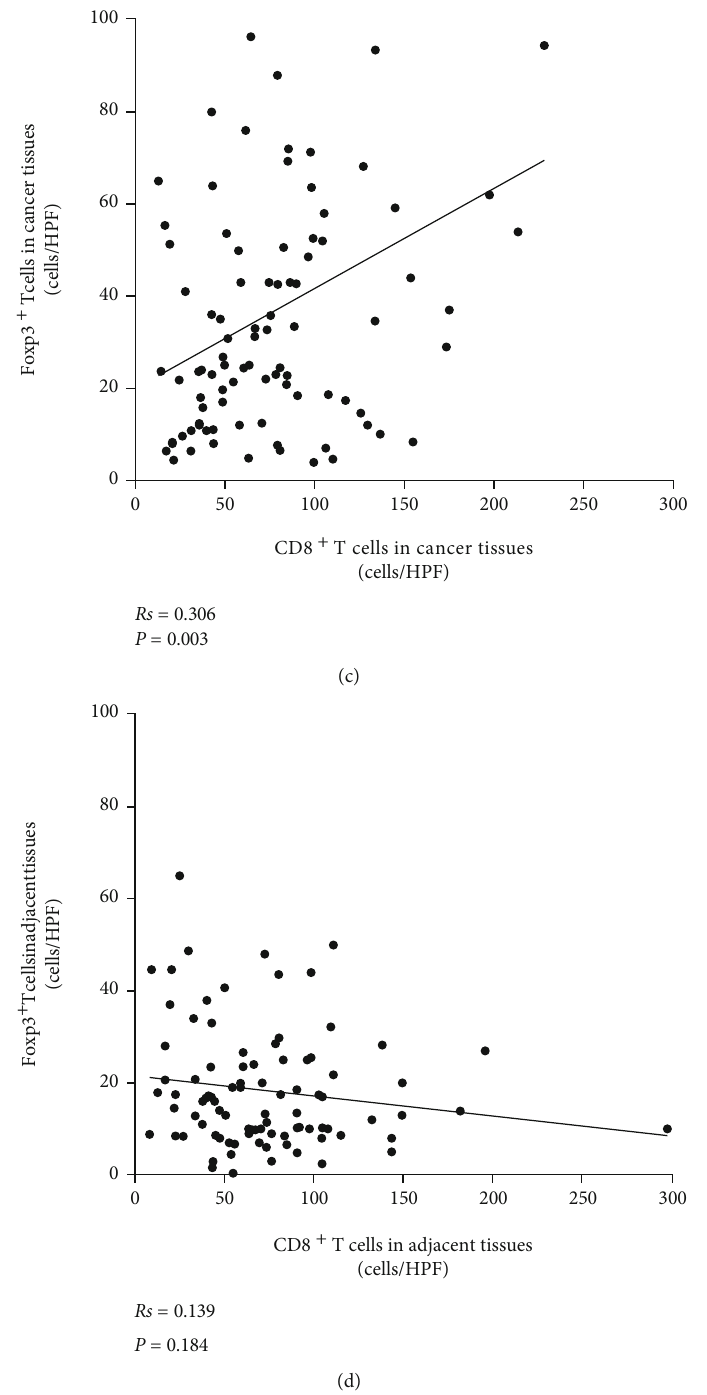
Figure 4: (a, c) Spearman correlation analysis showed a positive correlation among the CD4 + T cells and CD8+T cells with Foxp3 + T cells in tumor tissues ( p < 0 : 05 ); (b, d) no considerable or pronounced correlation was observed between CD4 + T: Foxp3 + T cells and CD8 + T: Foxp3 + T cells in normal adjacent tissues ( p > 0 : 05